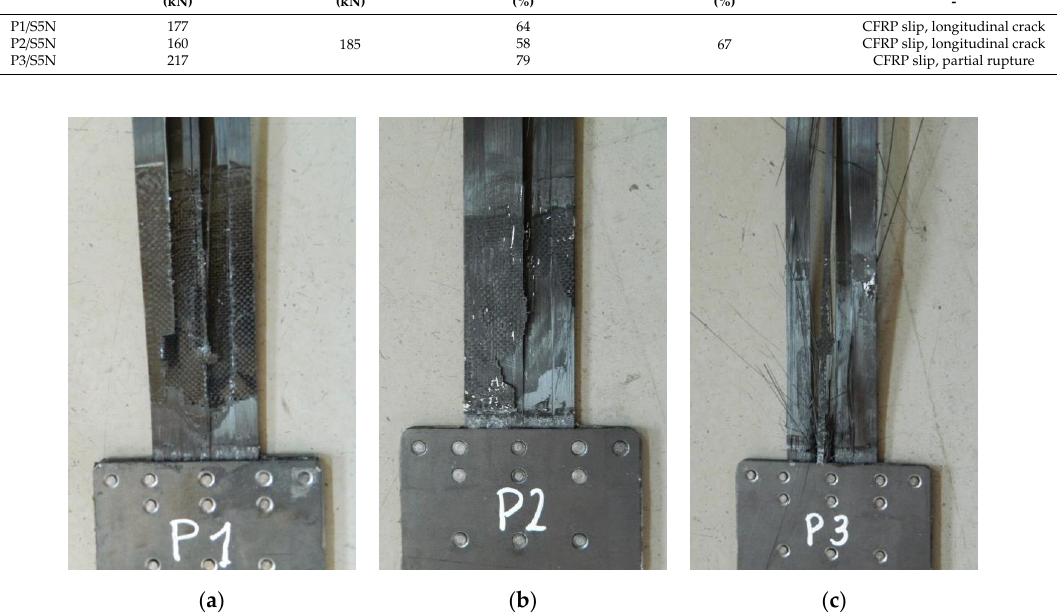
Figure 22. Failure mode of the subsequent specimens in the S5N series: ( a ) P1/S5N, ( b ) P2/S5N, ( c ) P3/S5N. ( c ) P3 /